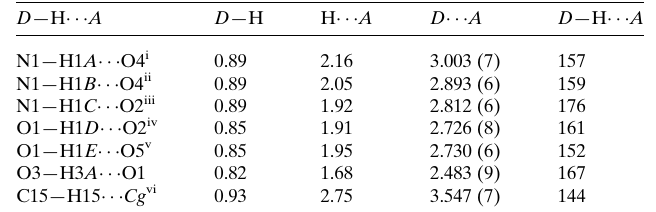
Table 1 Hydrogen-bond geometry (A˚ , (cid:4) ). Cg is the centroid of the C1–C6 aromatic ring.